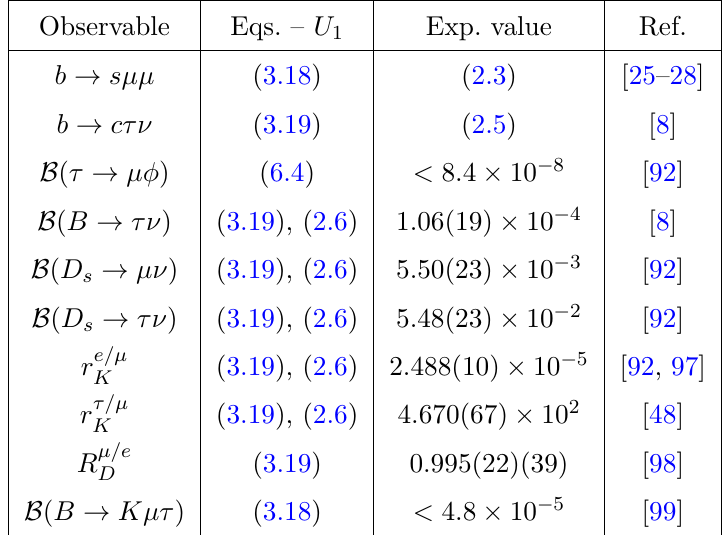
Table 3 . Tree-level observables considered in our phenomenological analysis and their correspond- ing experimental values (or limits), as well as their theoretical expressions for the U 1